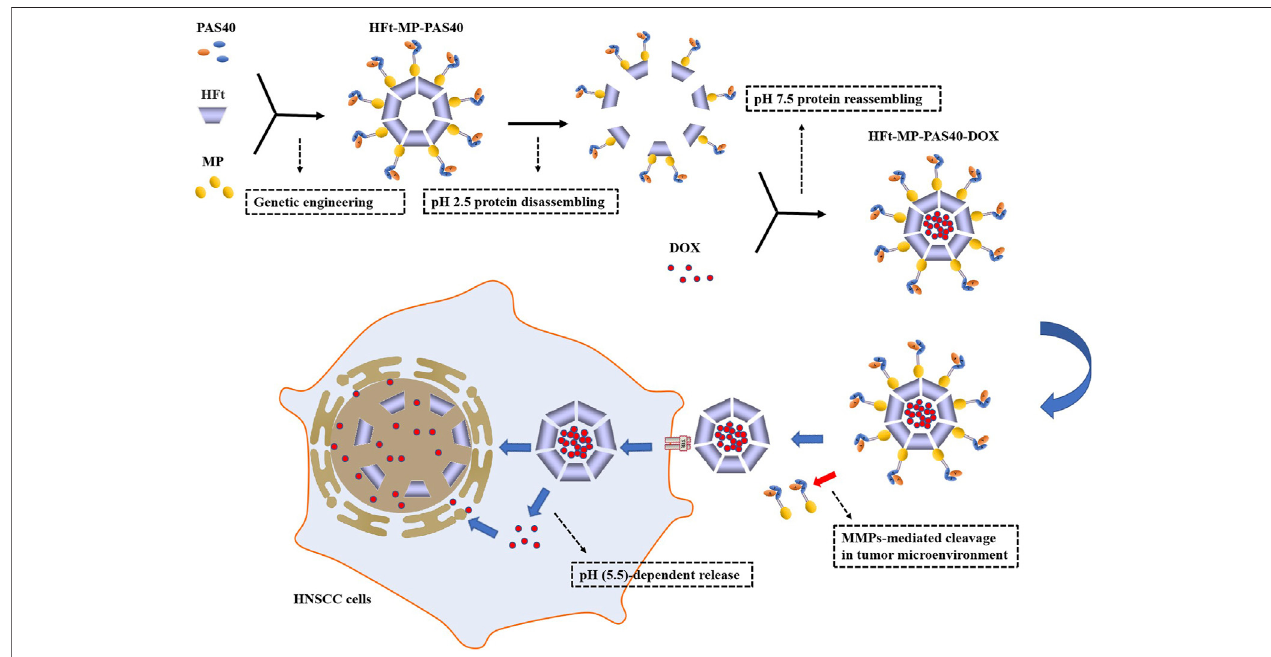
FIGURE7| AssemblyofHFt-basedconstructs,DOXencapsulation,andspeci fi ctumorsuppression.PAS40:apolypeptidesequenceof40residuesrichinproline (P), alanine (A), and serine (S) residues; MP: a short motif sequence for responding to proteolytic cleavage by tumor matrix metalloproteases (MMPs). HFt-MP-PAS40 is assembled from PAS40, MP, and HFt through genetic engineering. The protein disassembling at pH 2.5 and then reassembling at pH 7.5 is to encapsulate DOX at the sametime.PAS40canhampertheinteractionofDOX-loadedHFtwithTfR1onthesurfaceofnormalcells.MPbetweenHFtsubunitandtheouterPASpolypeptide is processed by MMPs – mediated cleavage in the tumor microenvironment to remove PASso that unmasked HFt can be speci fi cally taken up by TfR1 overexpressed in tumor cells. In addition to a part of DOX that is pH (5.5)-dependent released/translocated in the cytoplasm and then diffuses to the nucleus, most of it is released by degradation of HFt in the nucleus, which ultimately leads to HNSCC